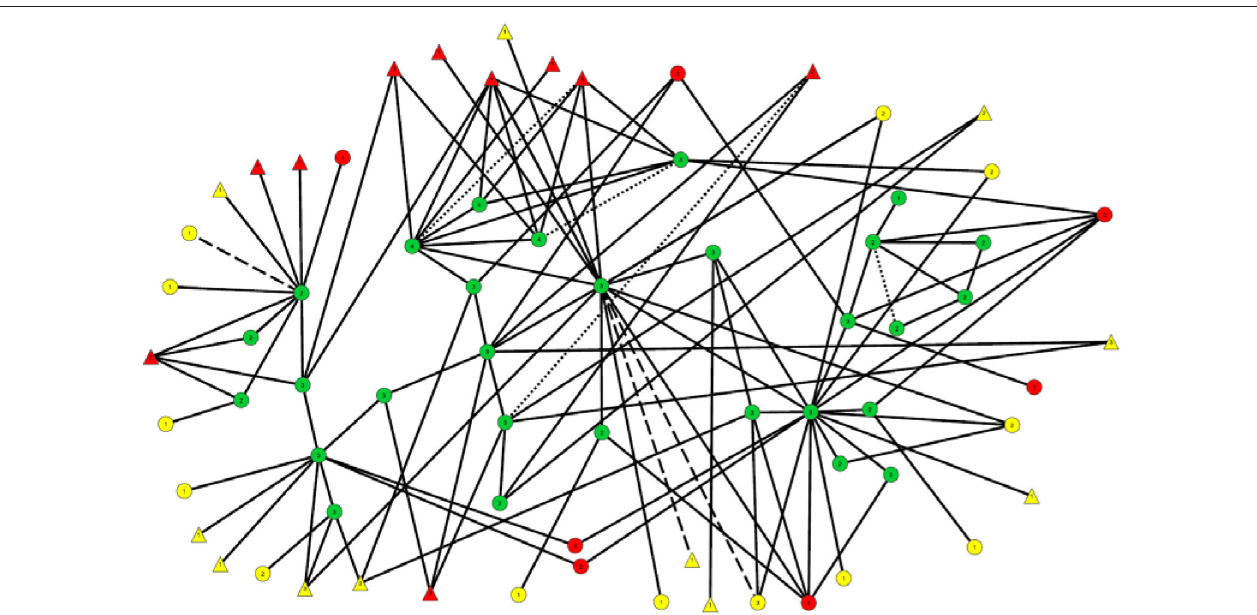
FIGURE 2 | Subnetwork of 29 uninfected participants and the recently- and long-term infected to whom they are linked. The nodes and links in this diagram are the same as those in the center of Figure 1 , although their locations have been modified to make this diagram easier to interpret. HIV infection status: Long term positives are marked in yellow. Recently-infected are in red. Uninfected persons are in green. Viral load: Triangles represent those with viral load > 100,000 copies/mL. Everyone else is represented by a circle. Link types: Solid line = Injection Link Dash line = Sex Link Small-Dotted Line = Both Sex and Injection